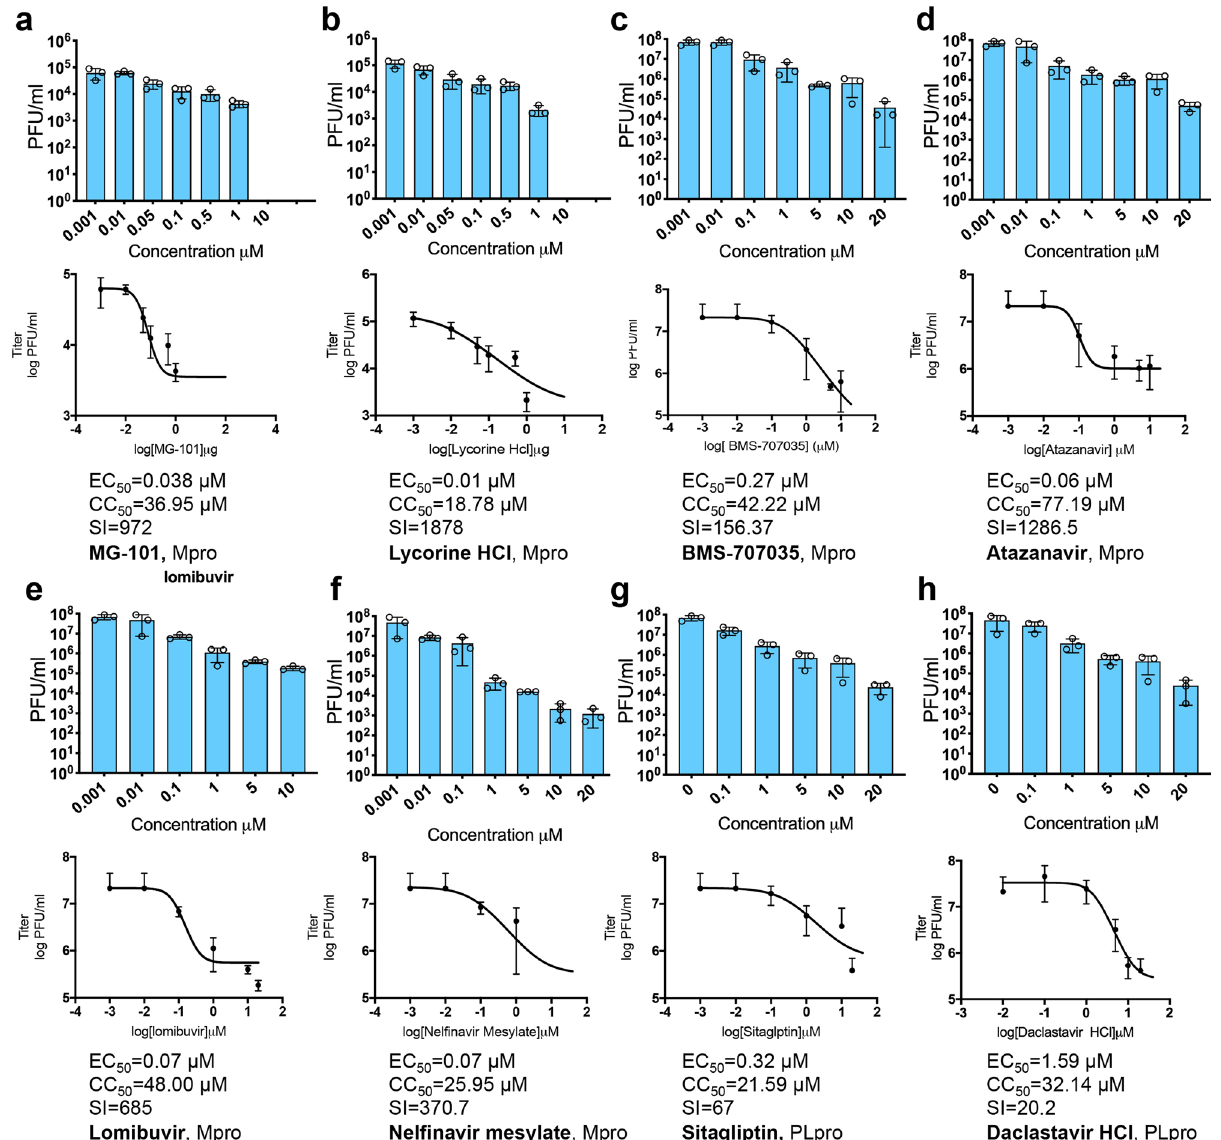
Fig. 4 Inhibition of SARS-CoV-2 replication in Huh-7.5 cells by compounds selected from ICP assay. Reduction in virus titers for different concentrations of compounds against Mpro ( a – f ) and PLpro ( g , h ) was determined by plaque assays ( n = 3). Dose-response curves were plotted, EC 50 (50% Effective concentration) was determined from plaque assay and CC 50 (50% cytotoxic concentration) was determined by alamarBlue reduction data. Selectivity index SI = CC 50 /EC 50